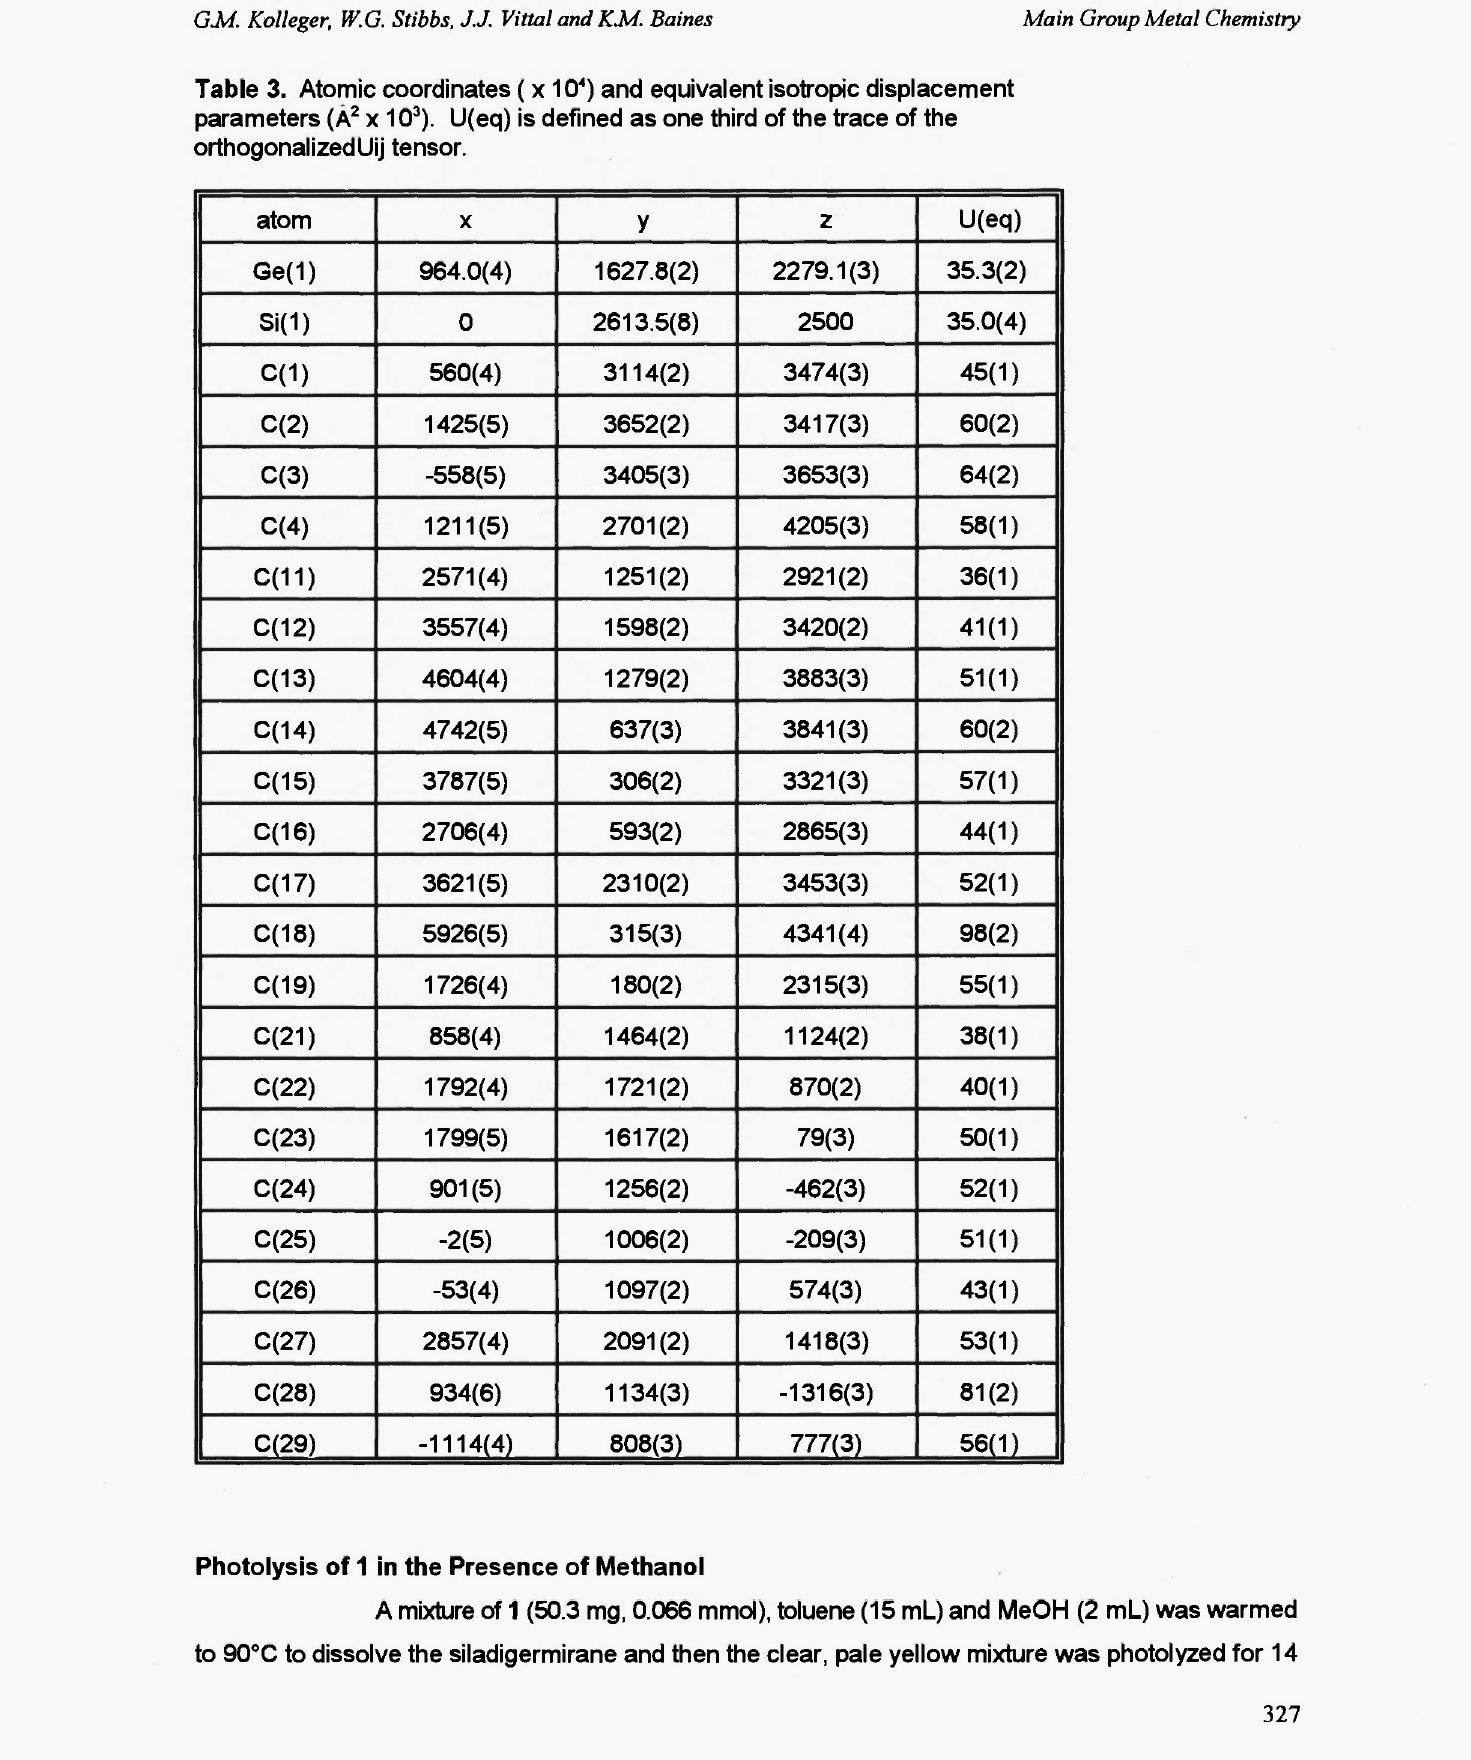
Table 3. Atomic coordinates (χ 10 4 ) and equivalent isotropic displacement parameters (Α 2 χ 10 3 ). U(eq) is defined as one third of the trace of the orthogonalizedUij